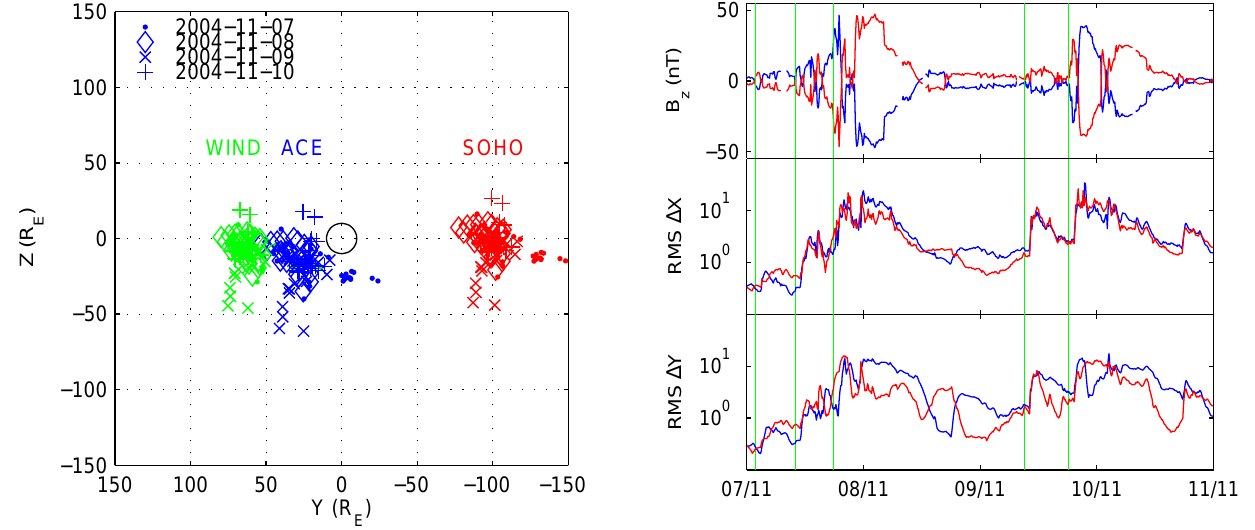
Fig. 4. The figure shows the advected spacecraft locations onto the plane X=10 R E using hourly average velocity vectors from WIND. The data have been divided into the four days: 7 November (dots), 8 November (diamonds), 9 November (crosses), and 10 November (pluses). The black circle is centred on Earth and has a radius of 10 R E .